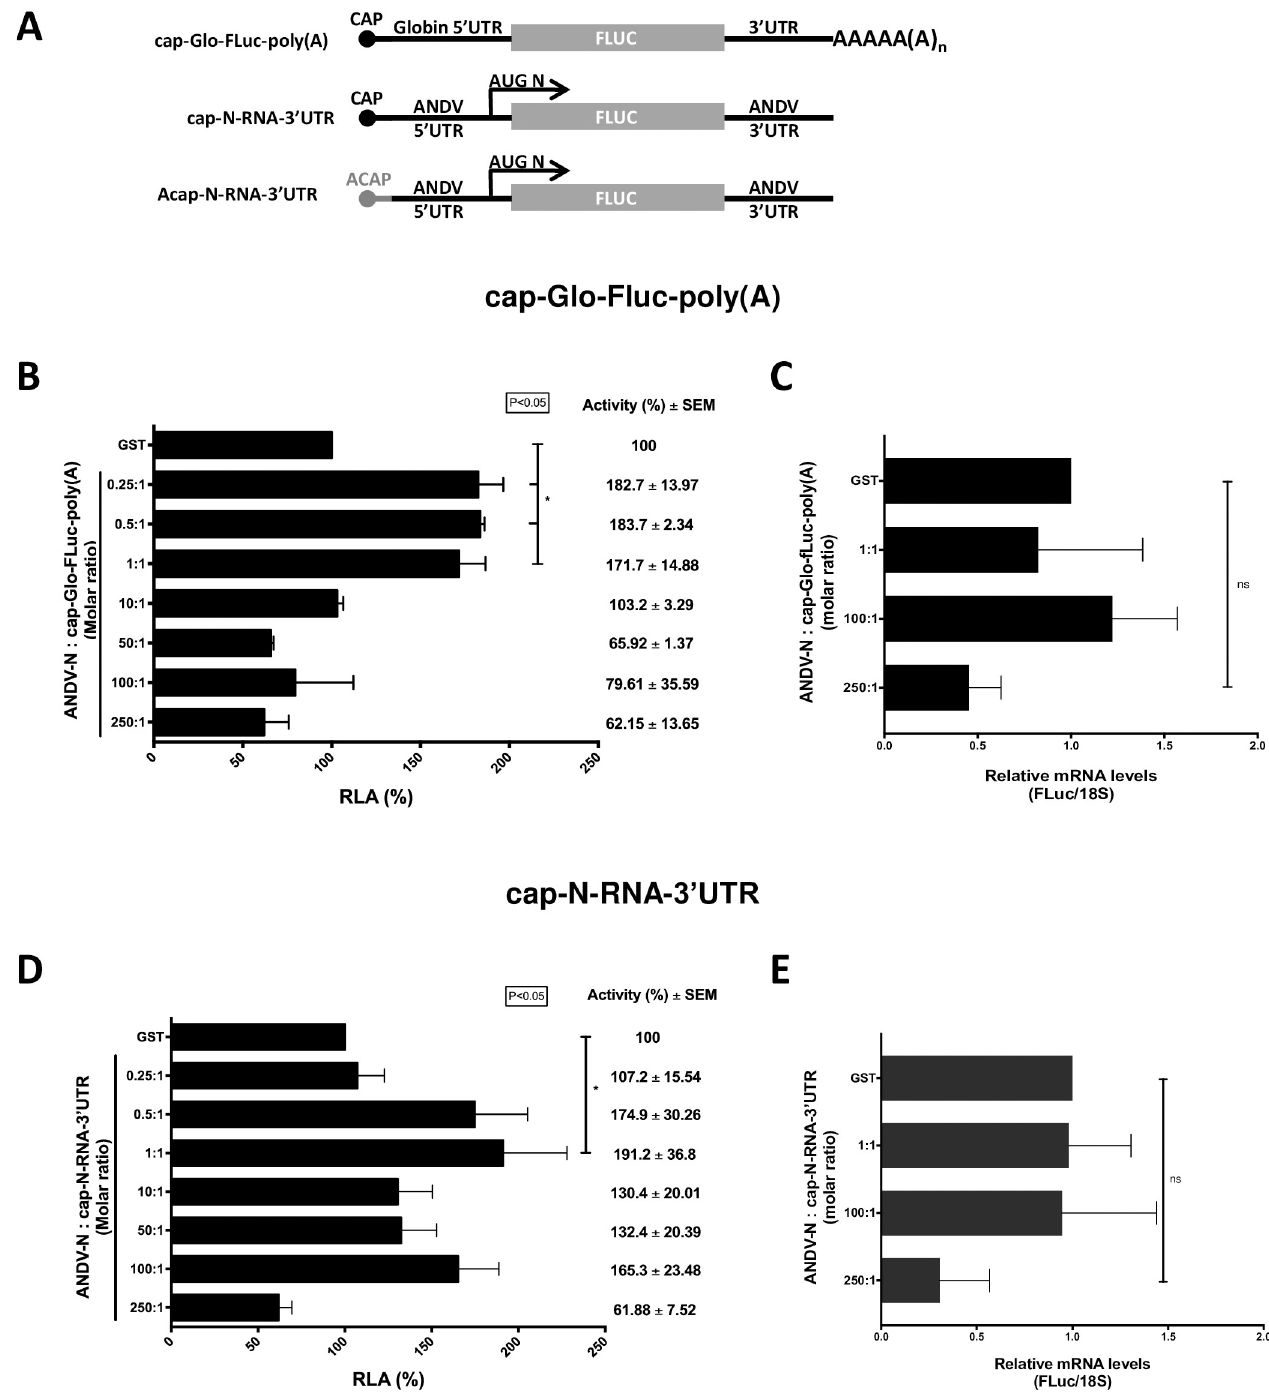
Fig 1. In vitro translation of ANDV-like SmRNAs in the presence of partially purified recombinant ANDV GST-N protein. (A) Schematic representation of the capped and polyadenylated Glo-FLuc RNA and capped ANDV like SmRNA, N-RNA-3’UTR [27], used in this study. In the ANDV like SmRNA RNAs, the FLuc reporter gene is in-frame with the ANDV-N protein initiation codon (depicted by the arrow) [27]. (B-E) In vitro translation (90 min at 30˚C) in nuclease-treated Flexi-rabbit reticulocyte lysate (RRL; 35% v/v) programmed with in vitro transcribed cap-Glo-FLuc-poly(A) (B-C), or the cap-N-RNA-3’UTR (D-E) RNAs (0.01 pmol) was conducted in the presence of increasing concentrations of the ANDV GST-N protein (protein/RNA molar ratio from 0.25:1 to 250:1). GST alone at a protein/RNA molar ratio of 1:1 was used as a control. Data are shown as ratios, the number of ANDV GST-N protein molecules added to each reaction, relative to the estimated number of cap-N-RNA-3’UTR molecules added to the reaction (6.02 x10 9 molecules/ μ L). The number of RNA molecules present in 0.01 pmol (6.02 x10 9 molecules) was estimated considering an RNA length of 2286 bp for cap-N-RNA-3’UTR, and 2086 bp for the cap-